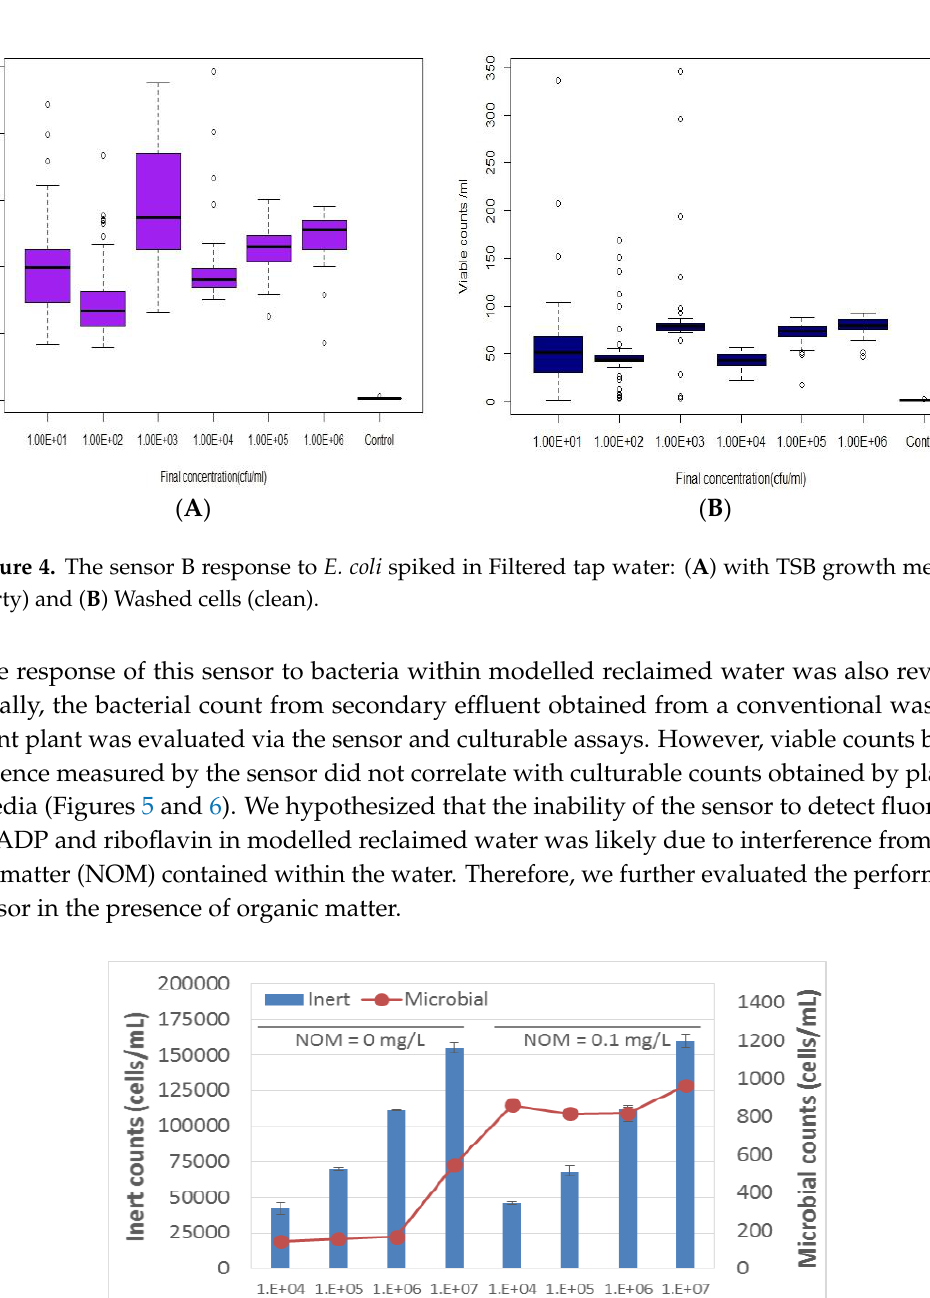
Figure 5. The Sensor B response to E. coli spiked in DI water with or without Natural Organic Matter (NOM).